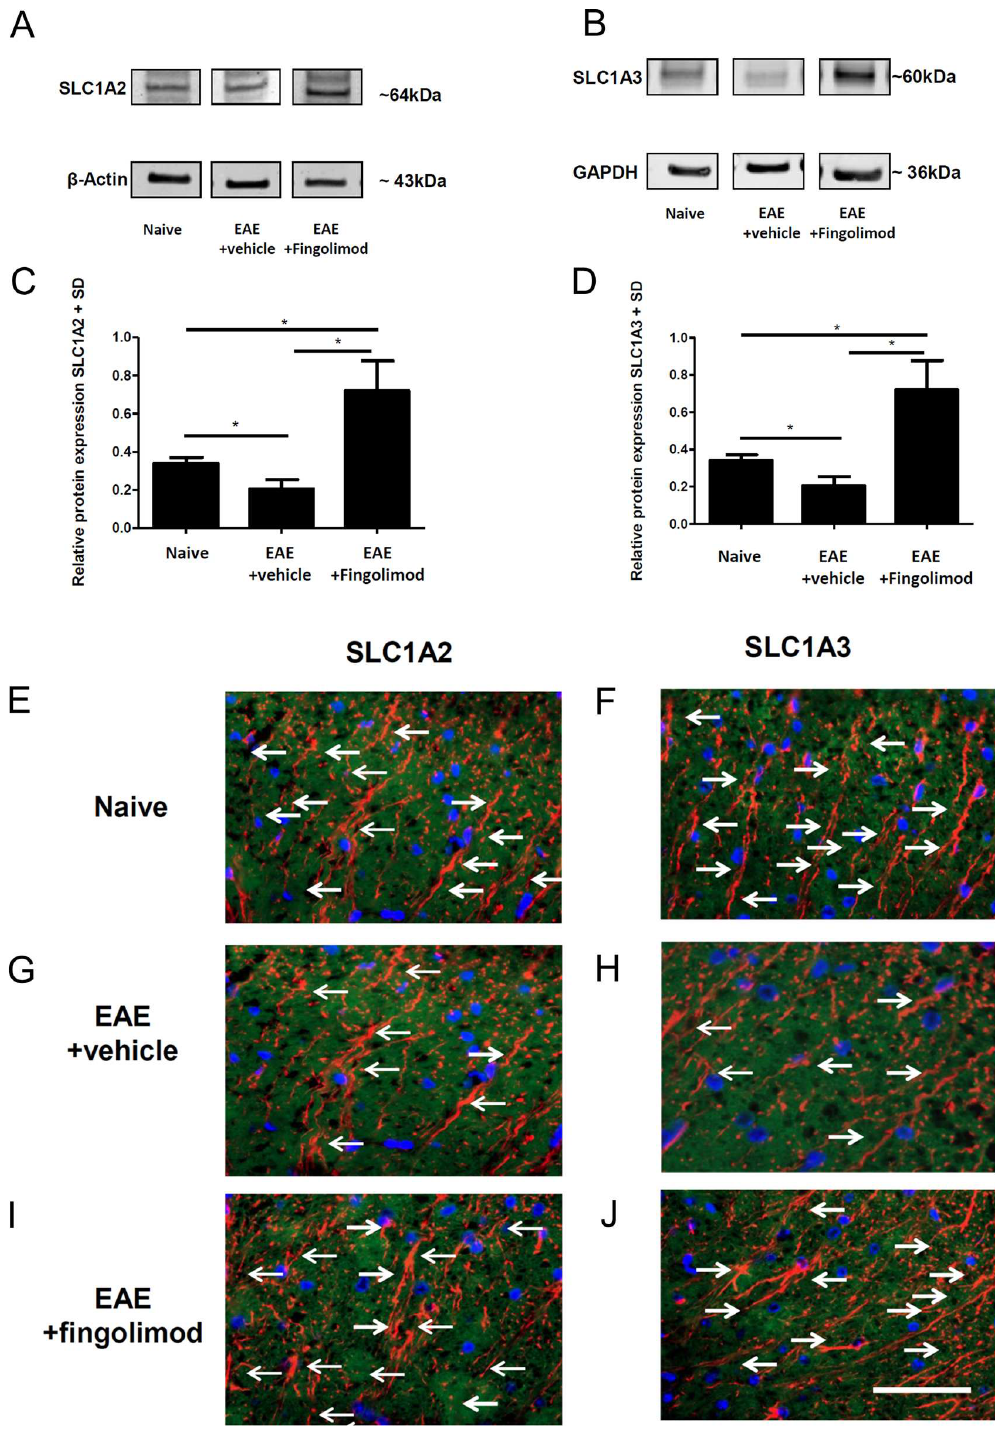
Fig 4. No effects of fingolimod on spinal cord glutamate transporterprotein levels during EAE. (A-D) Western Blot analysesof spinal cord homogenates relative to GAPDH (A) or beta actin (C) with the respective densitometry relativeto the housekeeping gene (B,D). At the maximum of EAE, there was a decrease for SLC1A2 (A,B) and SLC1A3protein levels (C,D) as comparedto na ï vemice which was restored after fingolimod treatment (3 mg/kg once daily). One out of three experiments is shown, n = 3 per group. (E-H) Laser scanningmicroscopy of spinal cord cross sectionsafter staining for GFAP (red) and SLC1A2 (green, E,F) or SLC1A3(green, G,H). Arrows indicate doublelabelledprofiles. Representative images of spinal cord cross sections are shown. Bar = 50 μ m.